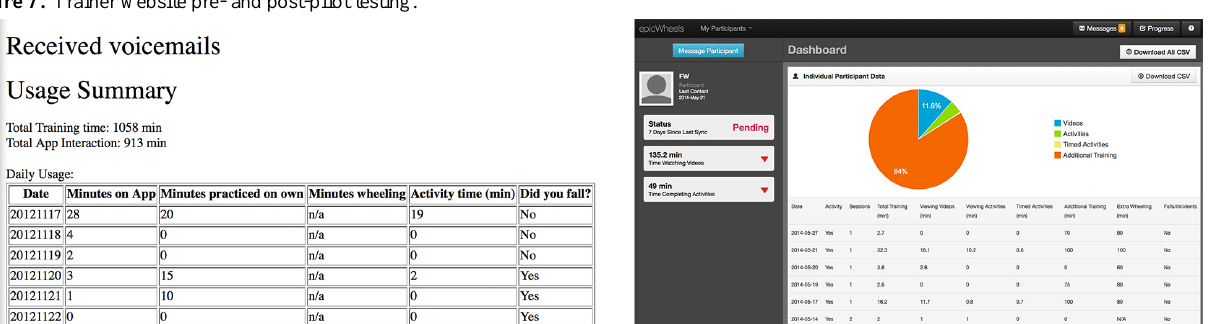
Figure 7. Trainer website pre- and post-pilot